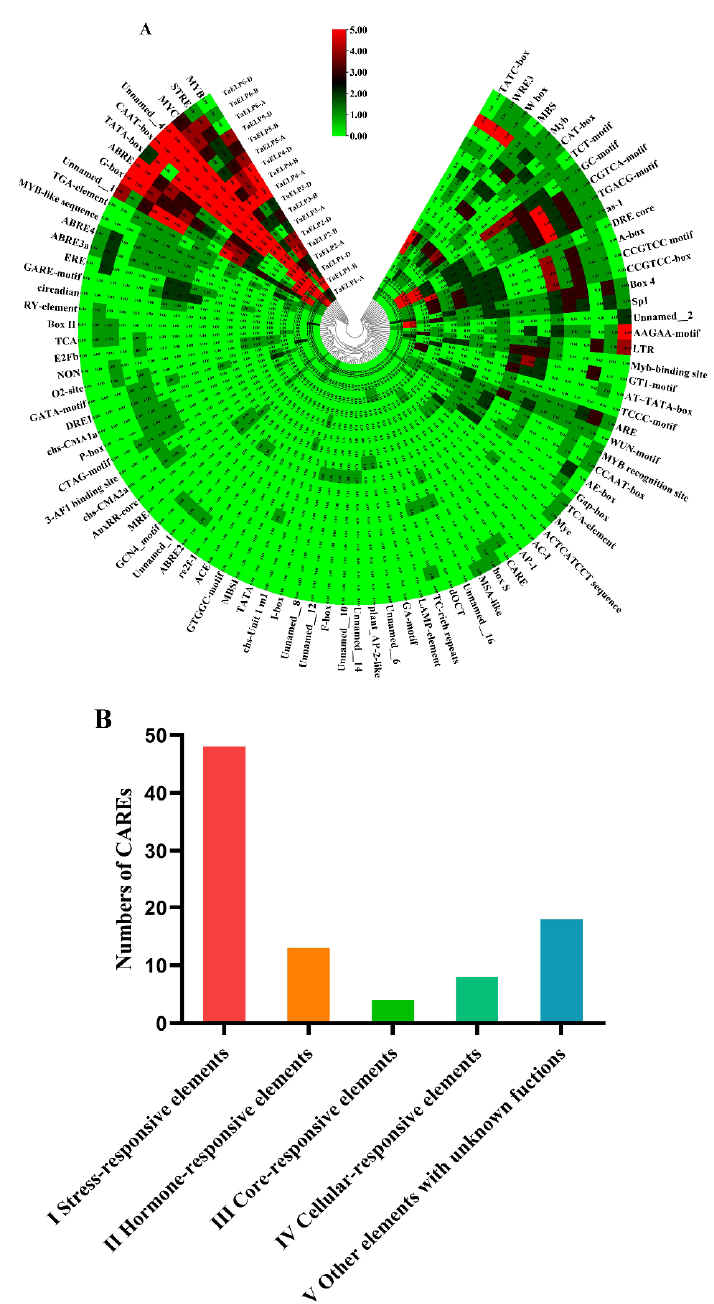
Figure 6. Cis-regulatory elements (CAREs) of the TaELP gene family. CAREs analysis of the 2 kb upstream region was performed using the PlantCARE online server. ( A ) Red indicates CREs with higher frequencies, while green indicates CREs with zero frequencies. ( B ) Grouping of CAREs in the TaELP gene family.